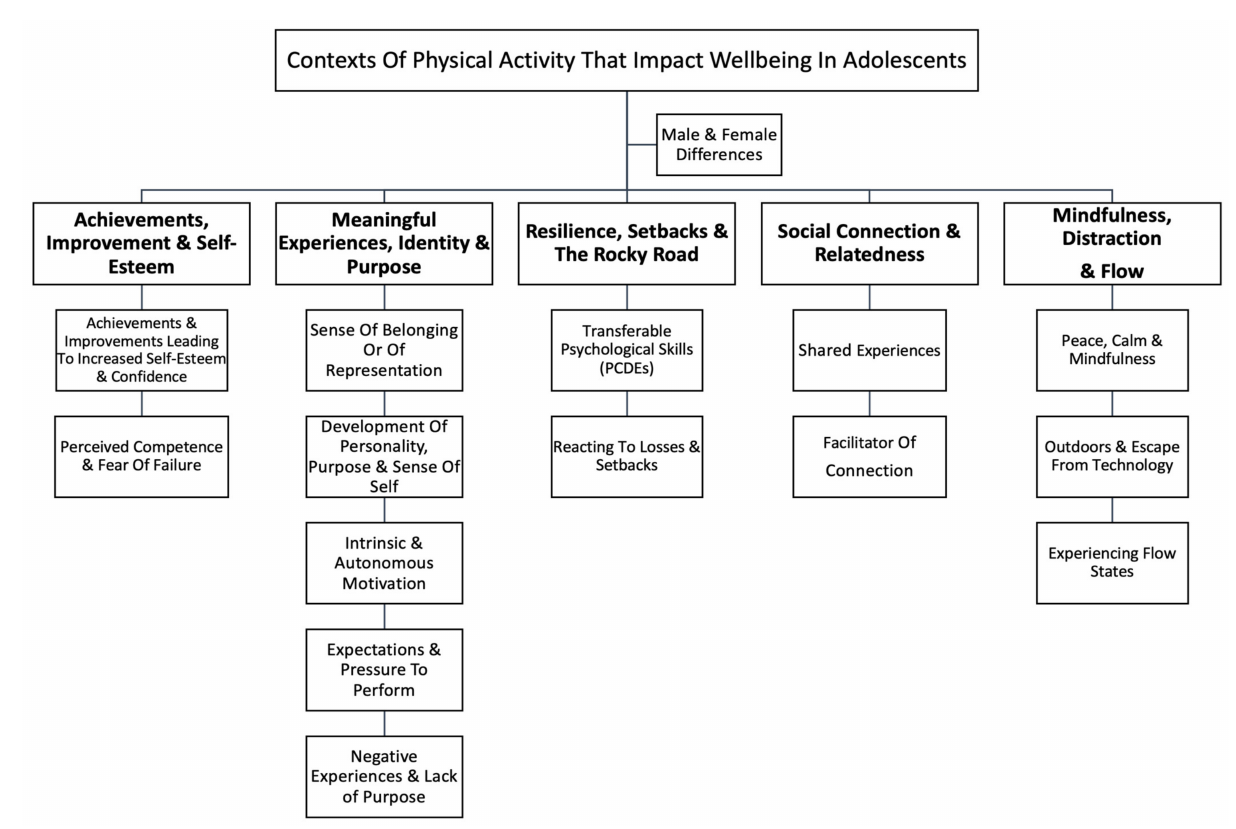
Figure 1. Adolescents perceived influences of physical activity and sport on mental